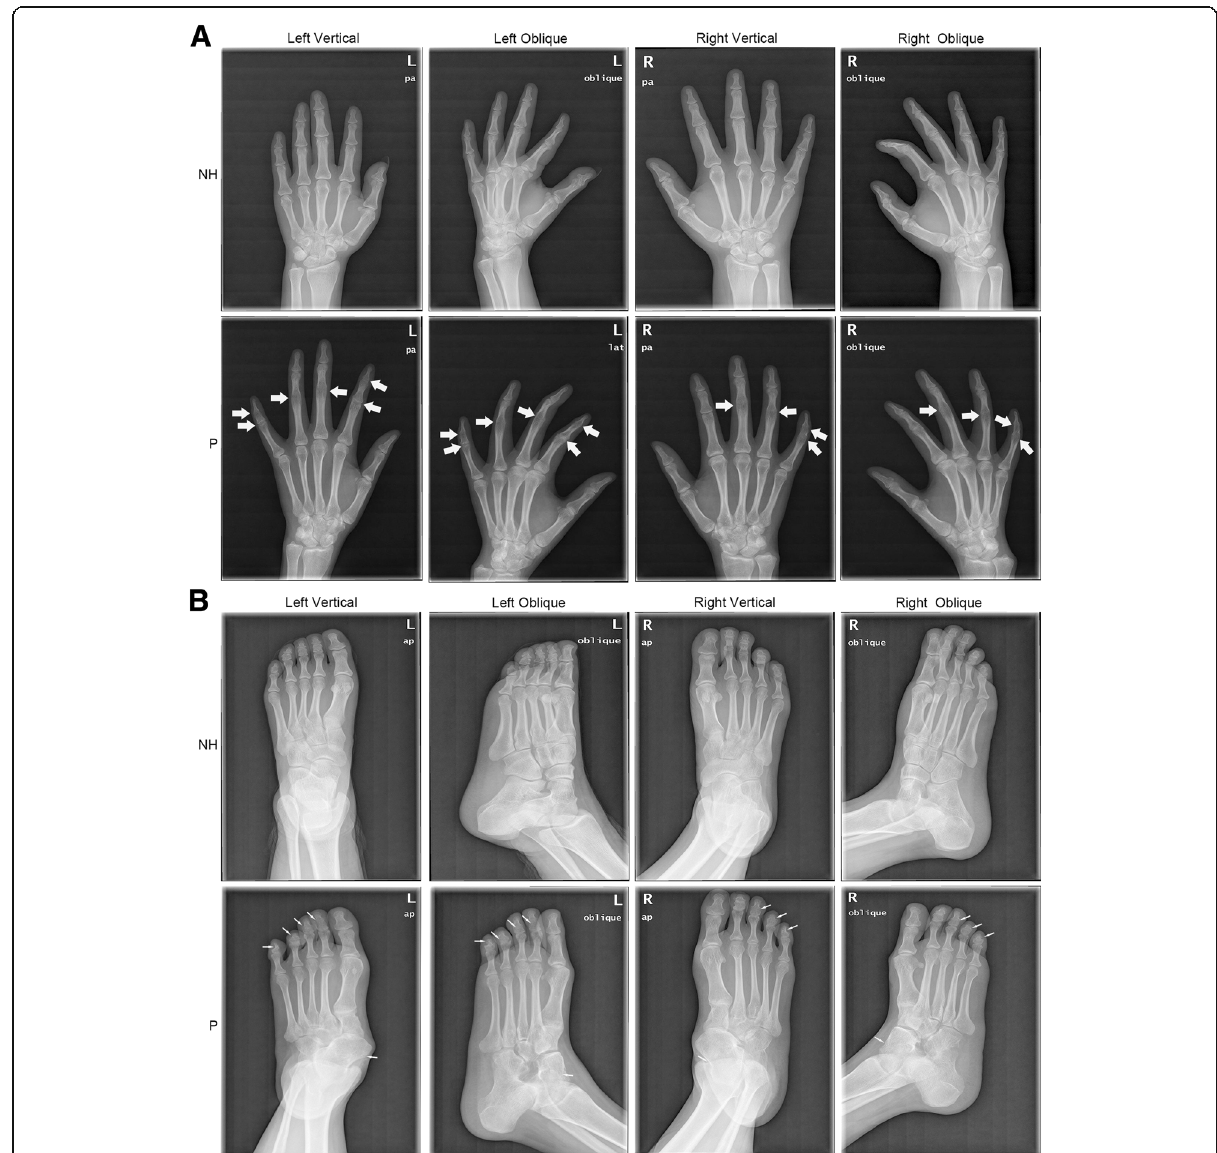
Fig. 2 Radiographs of hands and feet of the proband and her normal mother. a Vertical and oblique views of both hands are shown. Arrows indicate interphalangeal-joint fusion in the digits. b Vertical and oblique views of both feet are shown. Arrows indicate interphalangeal-joint fusion in the digits and talonavicular